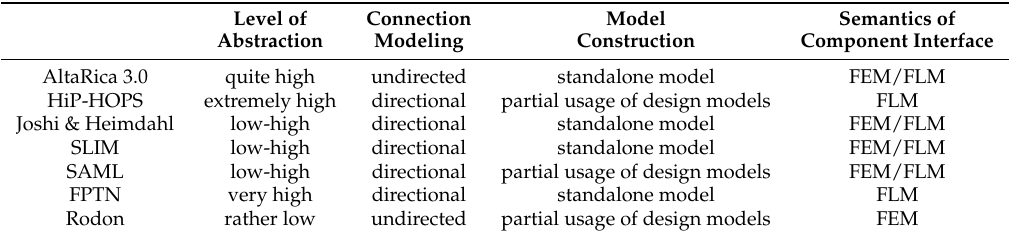
Table 1. Comparison of existing approaches to Model-Based Safety Analysis (MBSA).